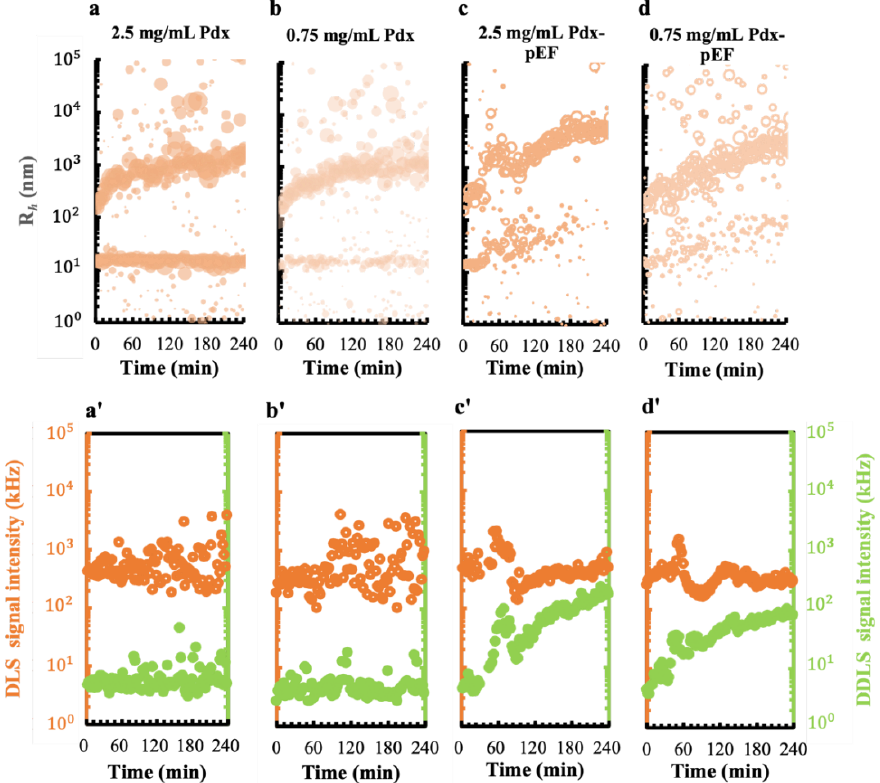
Figure 9. The effect of pEFs on early stages of Pdx crystallization at different protein concentrations. Kinetic evolution of the hydrodynamic particle radii from mixtures of 2.5 mg/mL Pdx with 5% PEG4000 ( a ) without and ( c ) with the application of a pEF, and mixtures at a final concentration of 0.75 mg/mL Pdx, 5% PEG4000 ( b ) without and ( d ) with a pEF. The corresponding DLS (orange open circles) and DDLS (green bubbles) signal intensities of each condition are shown in ( a ′– d ′ ).